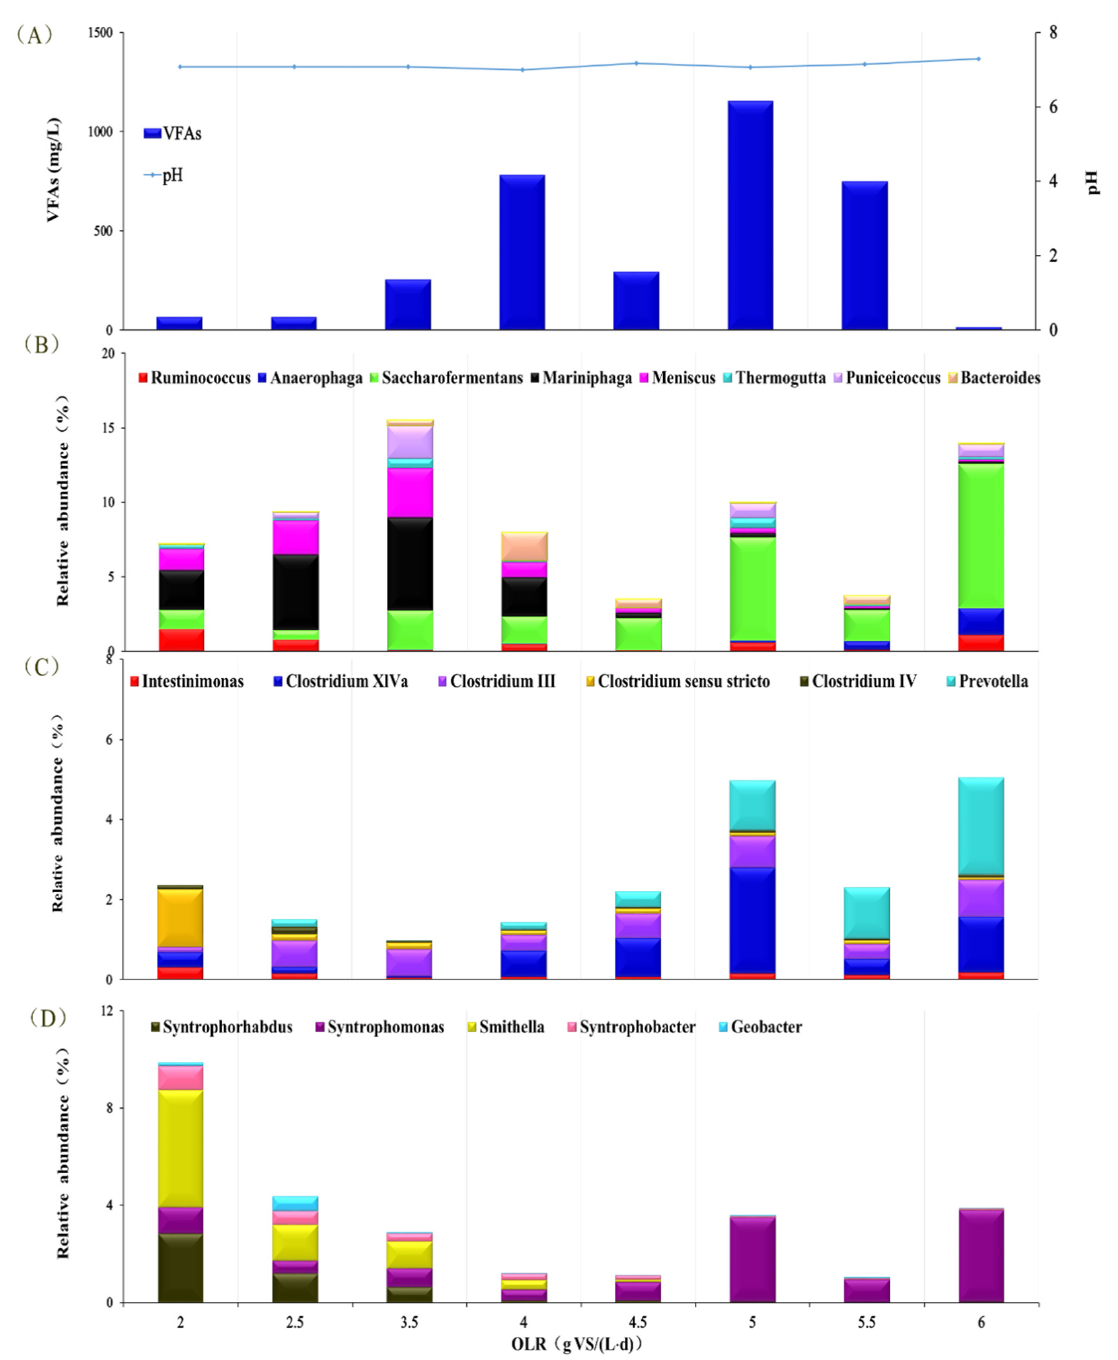
Figure 1. The pH, VFAs concentration, and the bacteria in genus level for GM11. ( A ) The values of pH and VFAs during the process. ( B ) The bacteria participated in the hydrolysis/acidogenesis phase. ( C ) The bacteria contributed to the accumulation of VFAs. ( D ) The bacteria involved in converting Pa and Ba.